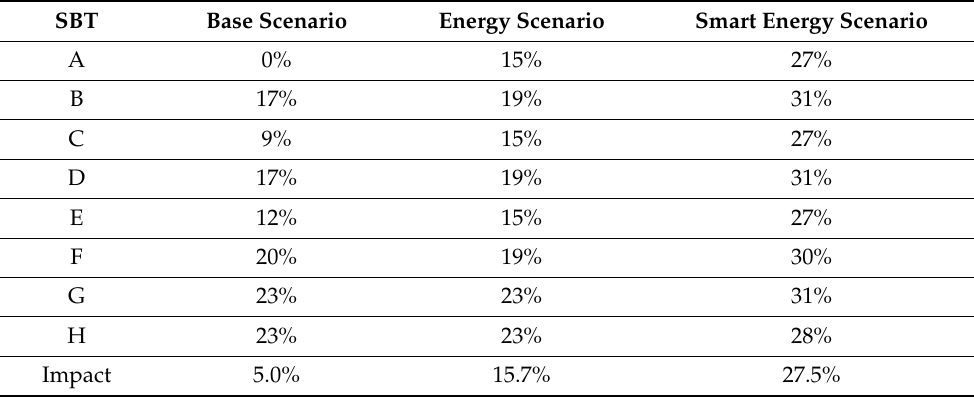
Table 9. Impact of retrofit interventions on the overall